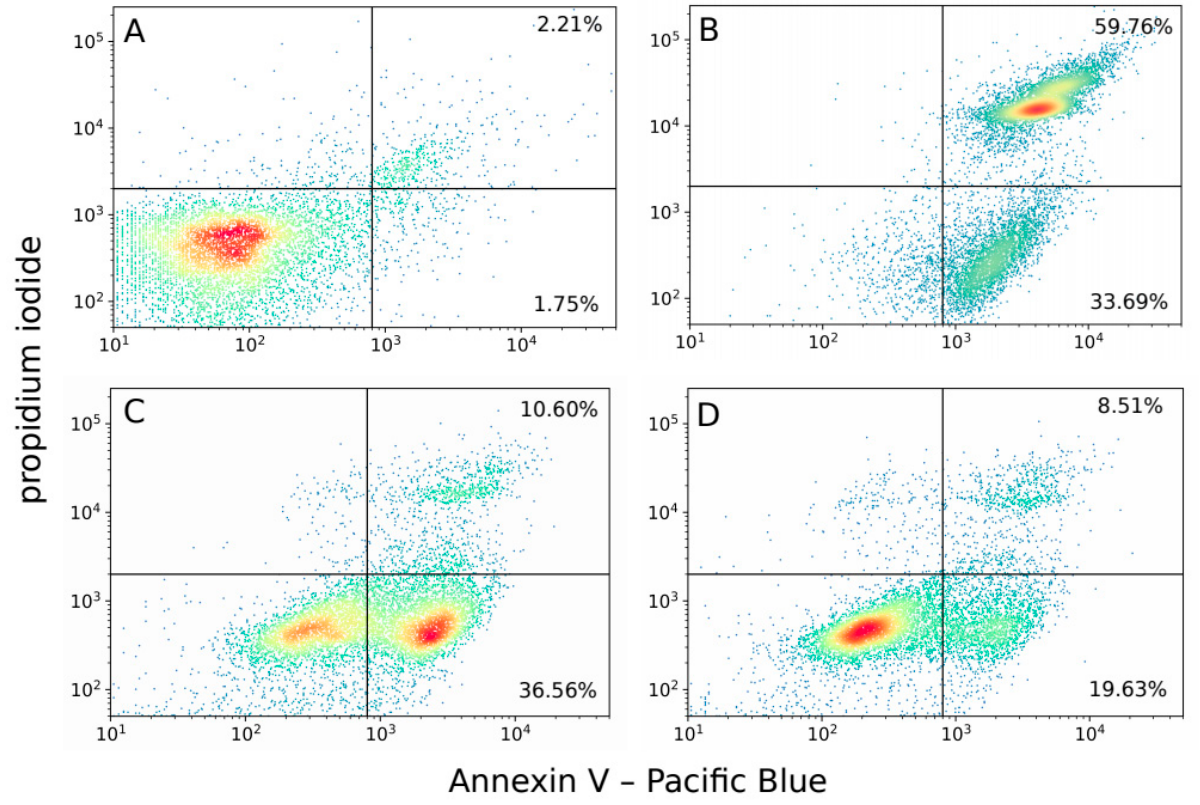
Figure 9. Flow cytometry analysis of HUVEC cells death mode after Zn-Pheide-induced PDT. The cells were stained with Pacific Blue-conjugated Annexin V and propidium iodide (PI), 30 min after irradiation. ( A ) Control cells, ( B ) cells treated with 1 µM Zn-Pheide without HSA, ( C ) cells treated with 100 nM Zn-Pheide without HSA, and ( D ) cells treated with 1 µM in the presence of 250 µM HSA. The percentage of cells undergoing early apoptosis (Annexin V—positive, PI—negative) and late apoptosis/necrosis (double-positive) is given.